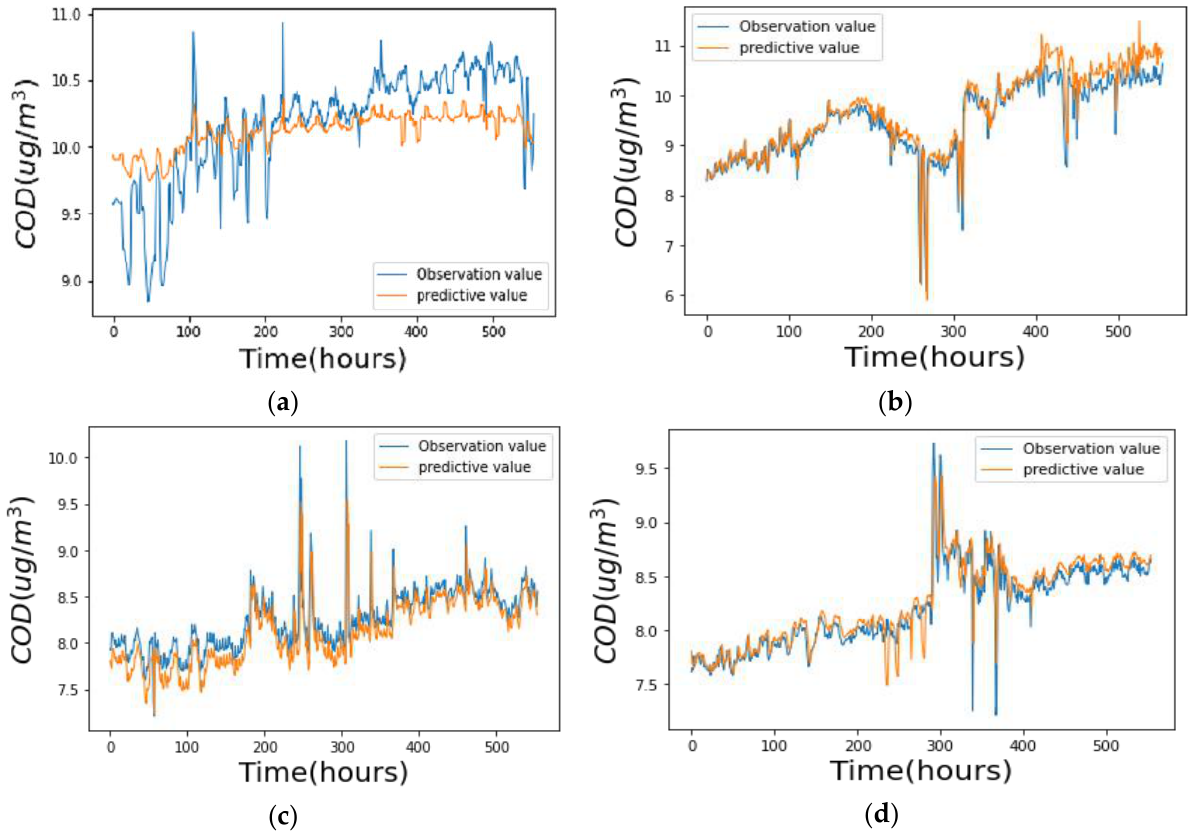
Figure 5. Fitting comparison of the MTL-CNN-LSTM model under each section. ( a ) Model fit trend comparison on Section 1. ( b ) Model fit trend comparison on Section 2. ( c ) Model fit trend comparison on Section 3. ( d ) Model fit trend comparison on Section 4.